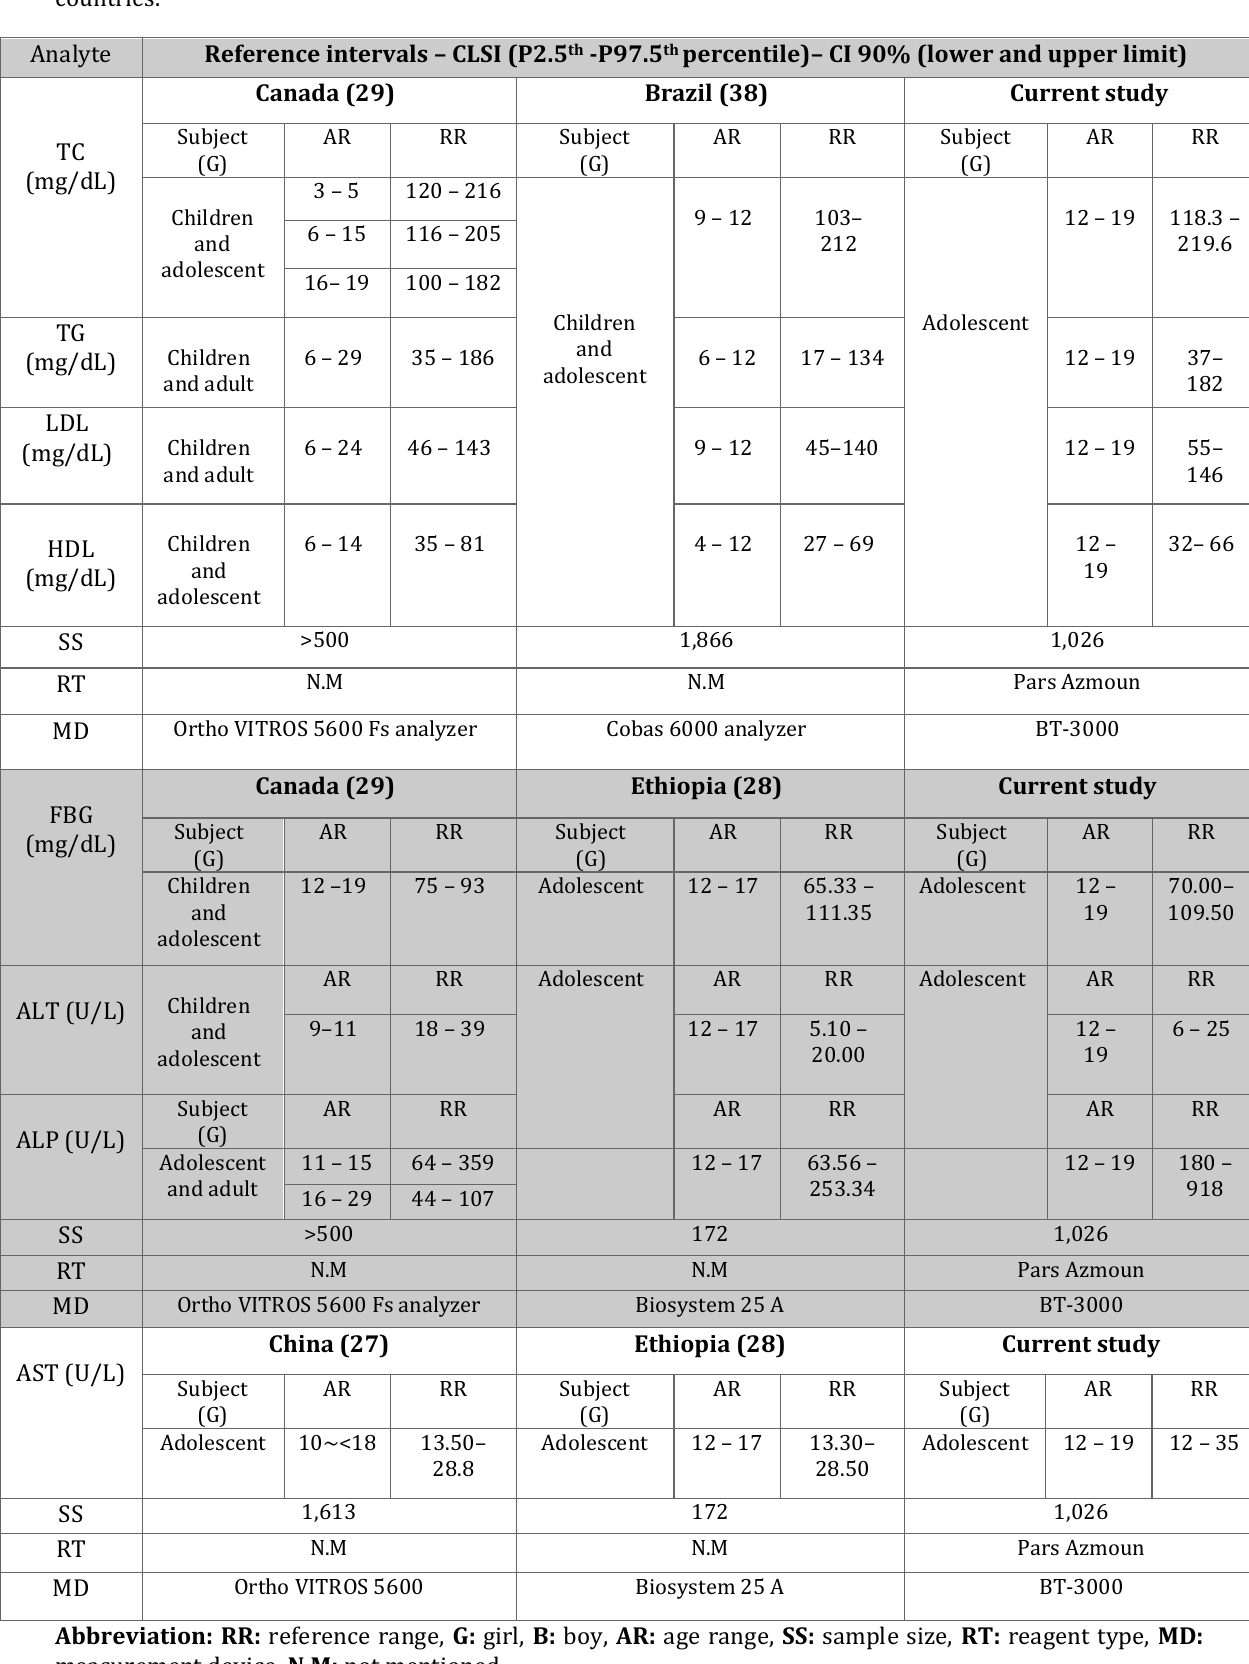
Table 2. Comparison of reference intervals of the current study population with reference intervals of other